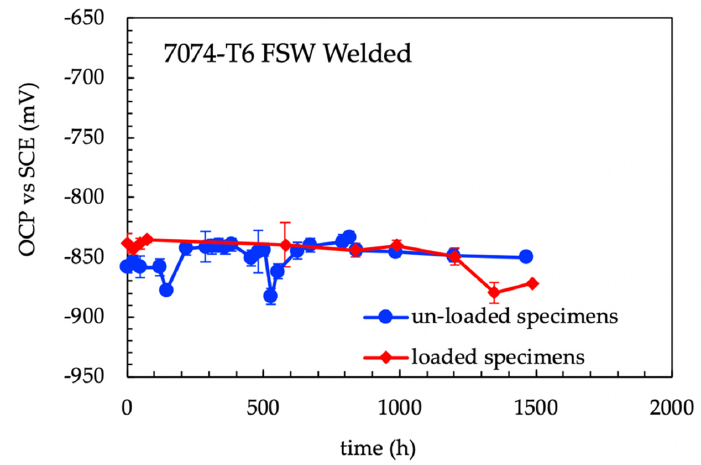
Figure 7. Open circuit potential (OCP) vs time for loaded and unloaded 4PBB specimens. The decreasing of the OCP of the specimens in the correspondence of the partial refresh of the test solution that breaks the aluminum oxide scale and exposes fresh metal surface to the aggressive solution.